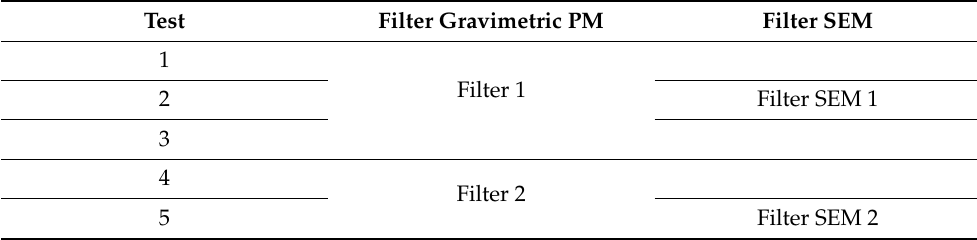
Figure 1. ( a ) Picture shows the spray chamber: spraying surface (green framed), spray gun (blue dot), low-cost OPC sensor, and two filter holders (red framed); ( b ) schematisation of the measurement room and instrumentation position; ( c ) picture shows the FF station at a distance of 4 meters with DustTrack II and DiSCmini. Table 2. Time-sheet of filters collected inside the spray chamber.